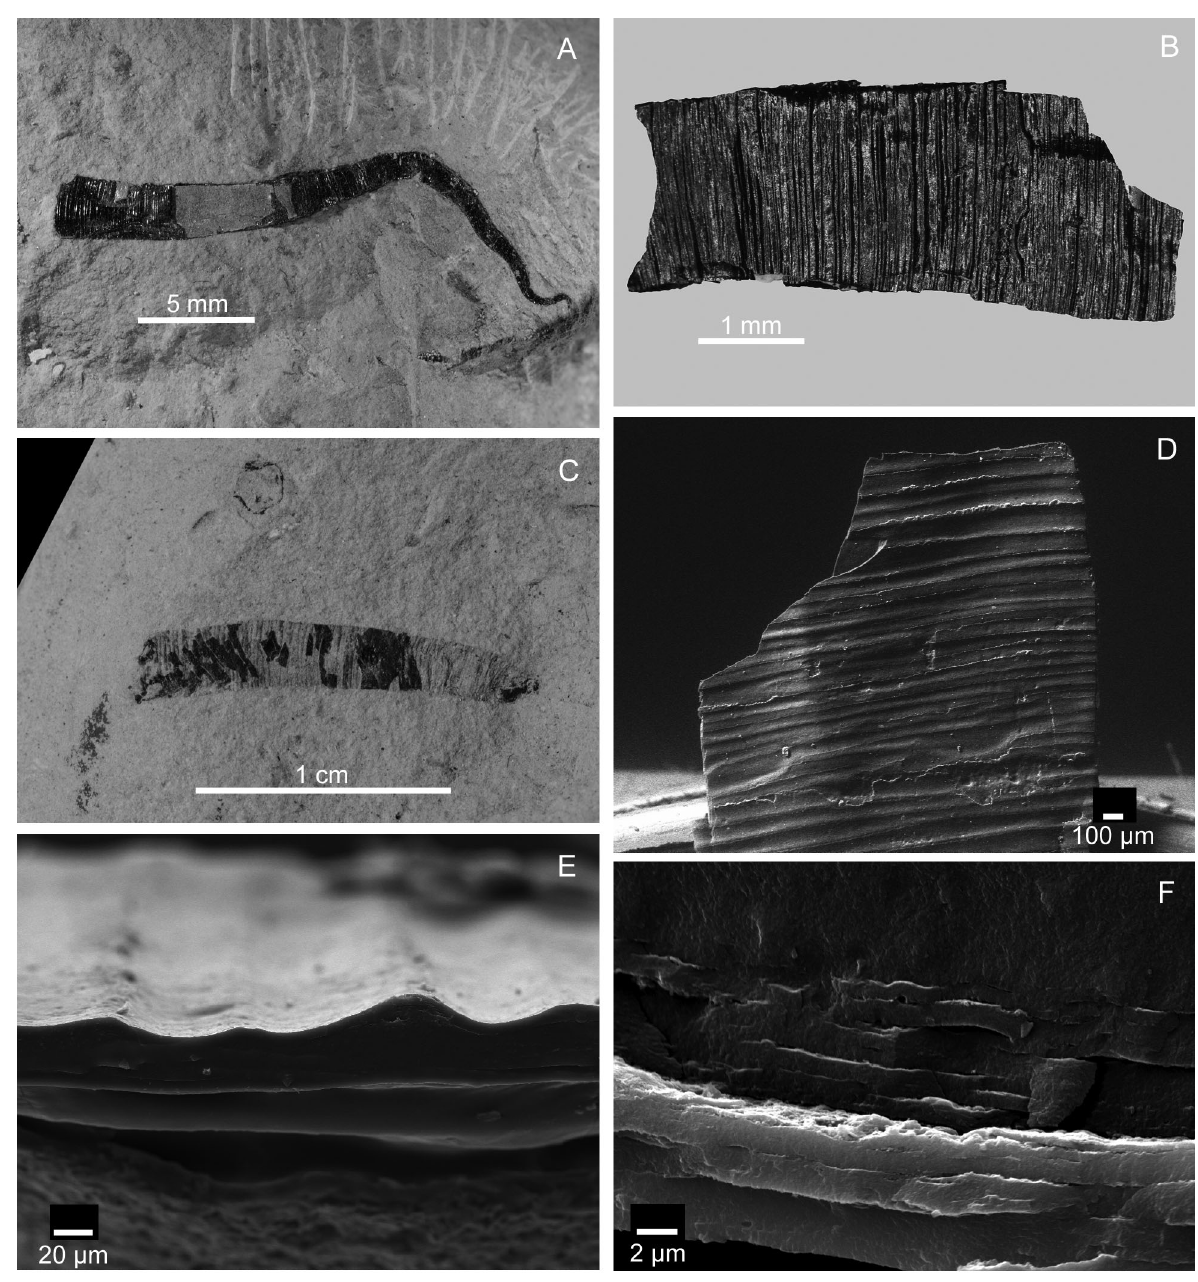
Fig. 2. Byronia jaegeri sp. nov. tubes from the Pirgu Regional Stage, upper Katian of Estonia. A , GIT 494-25, general view, Pärnu drill core; B , GIT 494-25, detailed view of perpendicular ornamentation; C , GIT 494-17, general view, Laeva drill core; D , GIT 494-25, detailed view of perpendicular ornamentation; E , GIT 494-25, longitudinal section showing lamellar micro- structure; F , GIT 494-25, transverse section showing lamellar